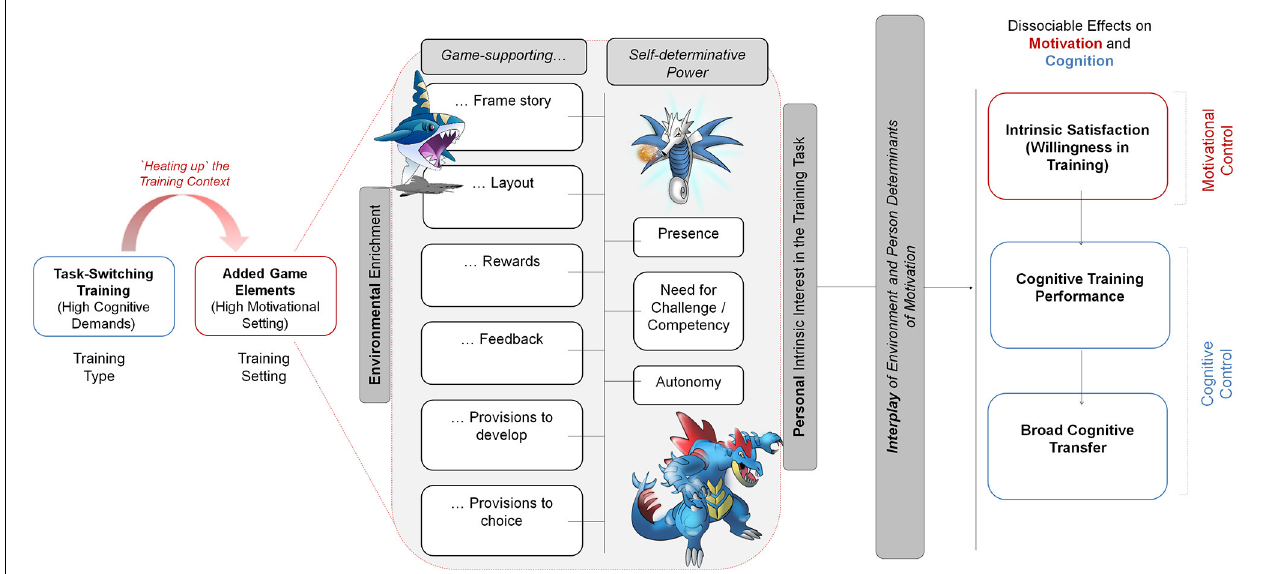
FIGURE 1 | Depiction of our proposed game-based framework for a task-switching training in middle childhood. The context (setting) of the cognitive-control training should be “heated up” by adding game elements. This environmental enrichment should induce self-determinative feelings, leading to the formation of a personal interest in the training